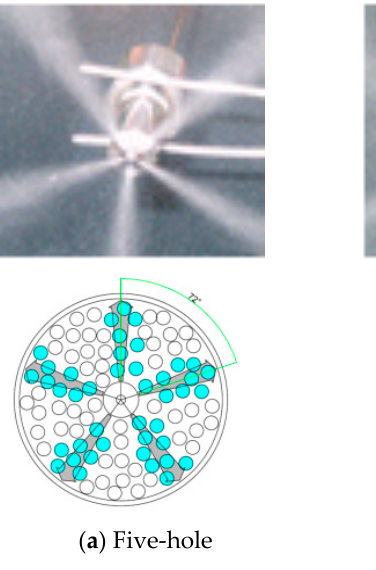
Figure 2. Shapes of fuel injection using five ‐ , six ‐ , and seven ‐ hole injectors, respectively.